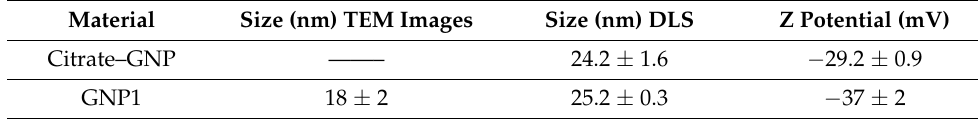
Figure 1. Changes induced in the aggregation of GNP1 in presence of GHB. Table 1. Size and zeta-potential measured for citrate–GNP and GNP1 in deionized water.